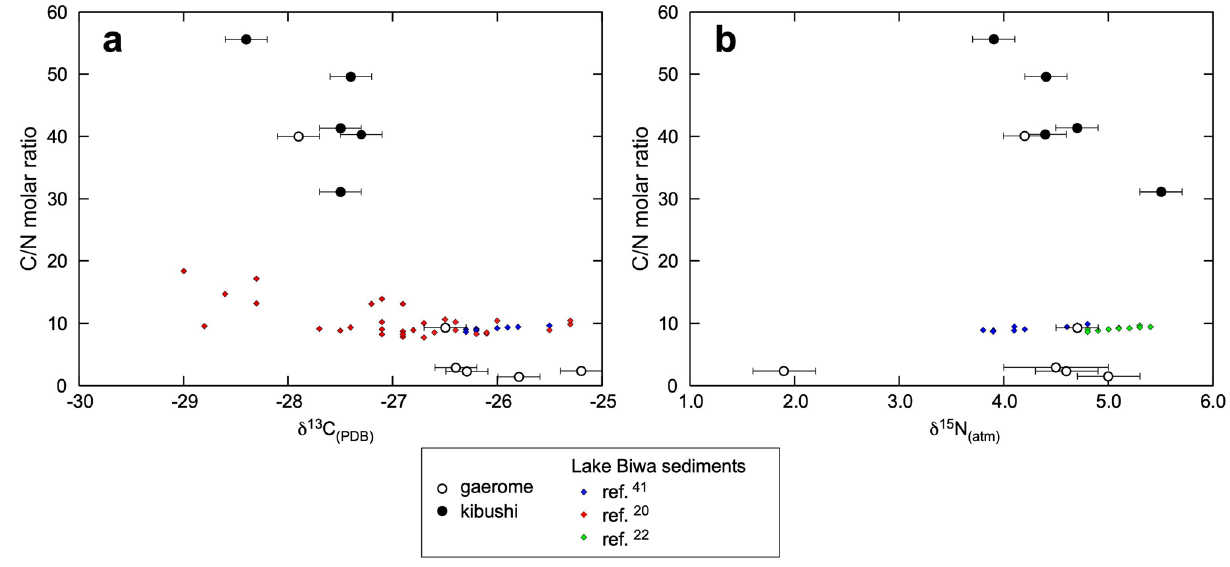
Figure 11. Graphs showing the relationships between δ 13 C and C/N molar ratios and between δ 15 N and C/N molar ratios in kibushi and gaerome clay and Lake Biwa sediments. In the compositions by Ref. 22 , data after 1950 were excluded to avoid anthropogenic effects such as nitrogen fertilizer.